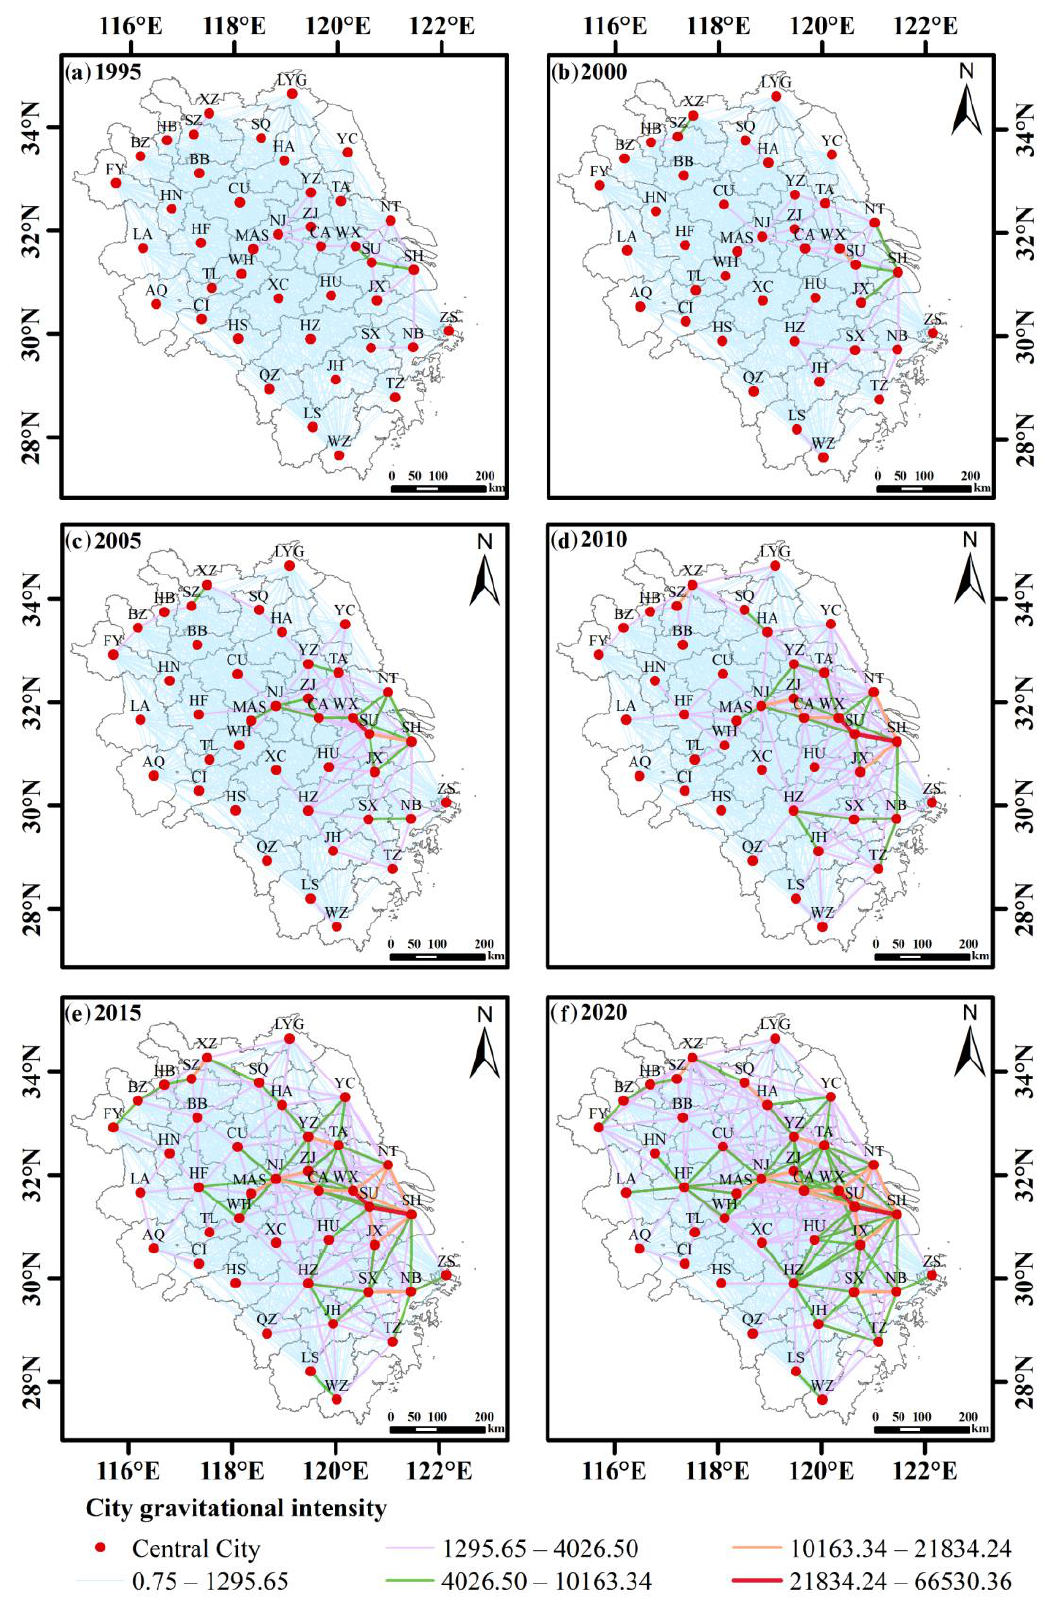
Figure 4. spatial correlation network (SCN) of land pressure in the YRDR in 1995, 2000, 2005, 2010,